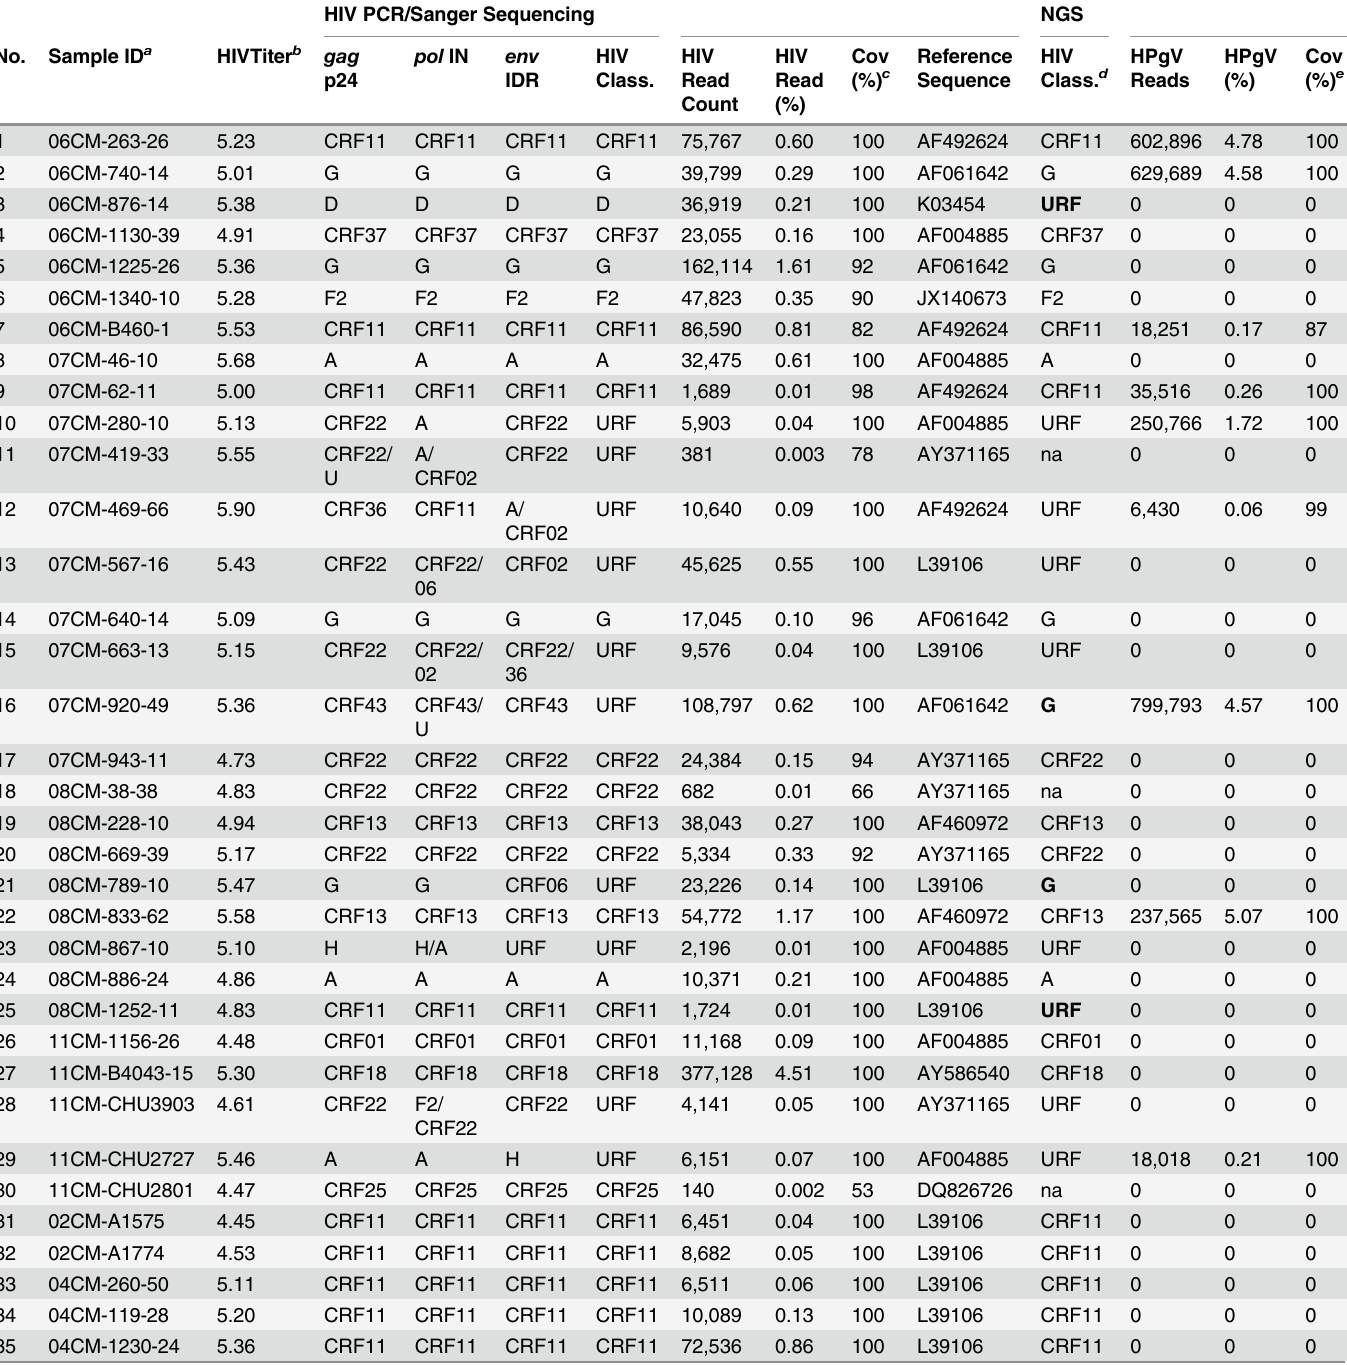
Table 1. Phylogenetic classification and next-generation sequencing results for HIV-infected Cameroonian blood